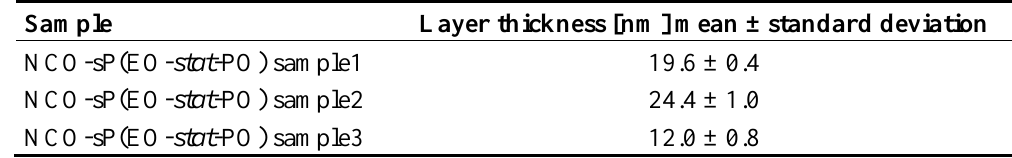
Table 2. Determination of layer thickness and homogeneity of the coatings with